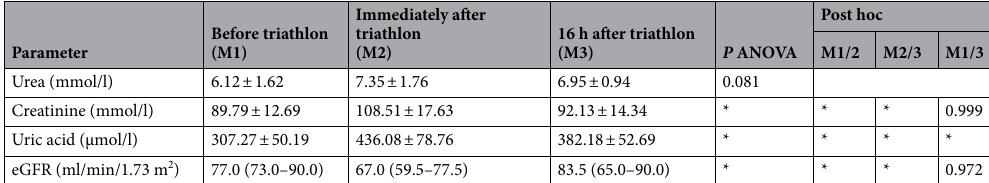
Post hoc M1/2 M2/3 M1/3